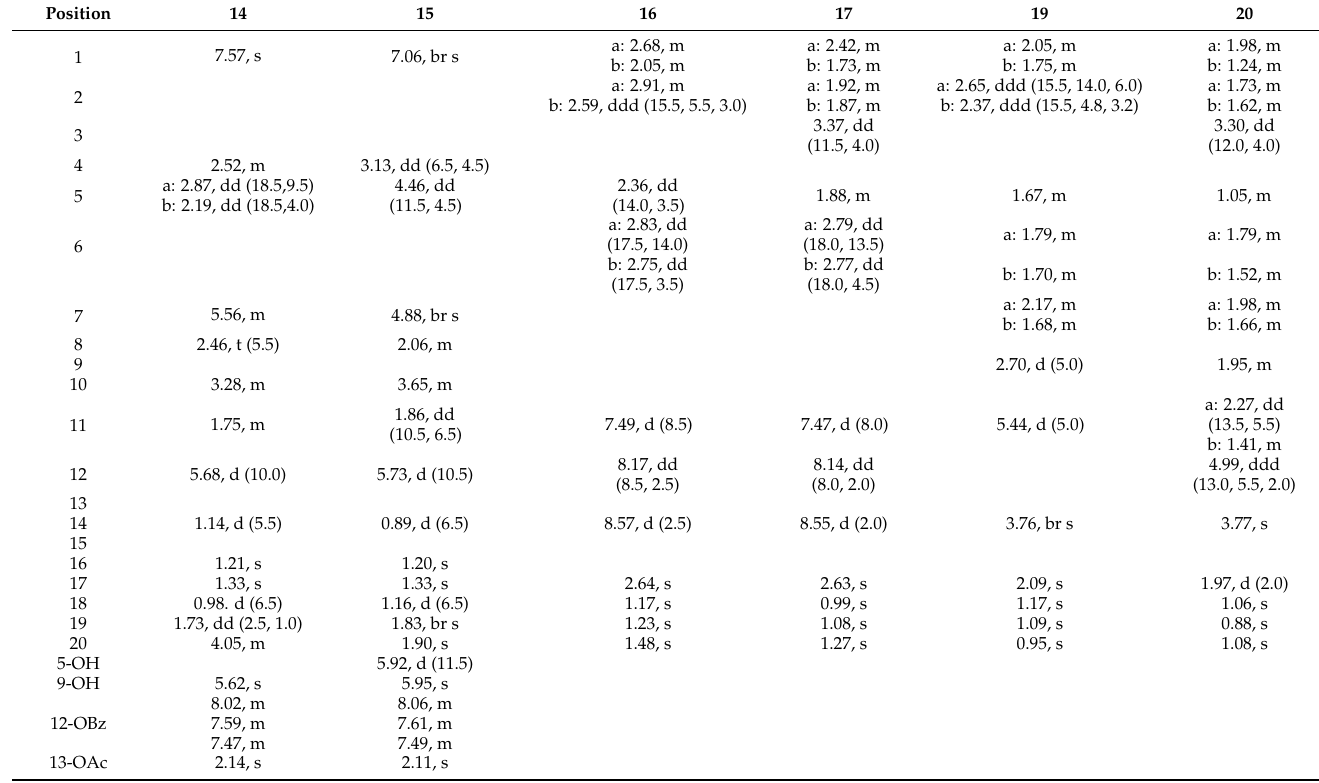
Table 4. 1 H NMR data of compounds 14 – 17 , 19 , and 20 in CDCl3 at 500 MHz ( δ H in ppm, mult. J in